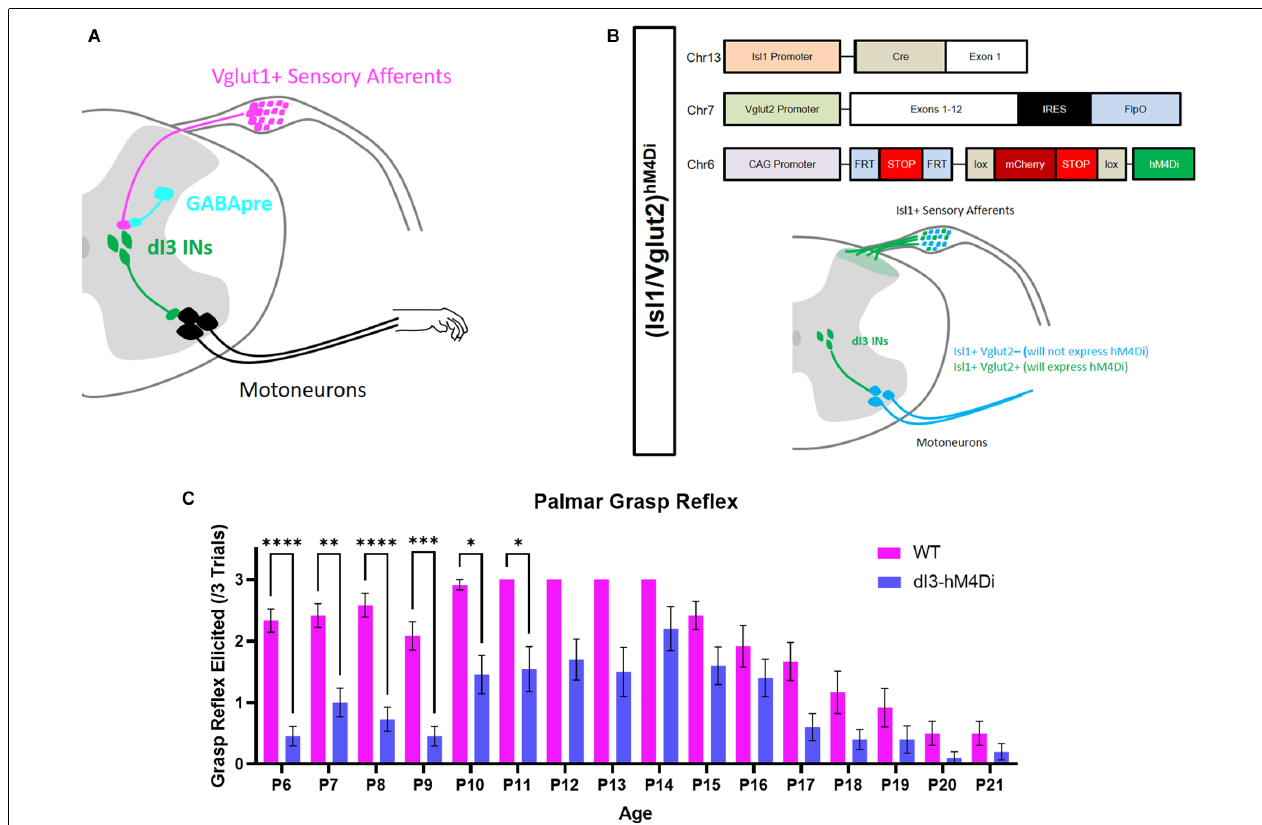
FIGURE 1 | Involvement of dI3 INs in forelimb palmar grasp reflex during postnatal development. (A) Putative circuitry involving GABApre presynaptic inhibition of Vglut1+ sensory inputs to dI3 INs. dI3 INs directly excite motoneurons, some of which may be involved in the palmar grasp reflex and mature grasping. (B) Diagram of genetics and expression pattern of (Isl1/Vglut2) hM4Di mice. Incidence of the forelimb palmar grasp reflex during postnatal development in (C) Isl1:YFP ( N = 12) and (Isl1/Vglut2) hM4Di ( N = 10) mice after the administration of the DREADD agonist JHU37160 (subcutaneous 0.5 mg/kg). A statistically significant reduction in the elicitation of the palmar grasp reflex was observed in (Isl1/Vglut2) hM4Di mice (Mixed Effects Model, Sidak’s post-hoc ). Each animal was tested at every time point. Error bars represent ± S.E.M., ∗∗∗∗ p < 0.0001, ∗∗∗ p < 0.001, ∗∗ p < 0.01, ∗ p <